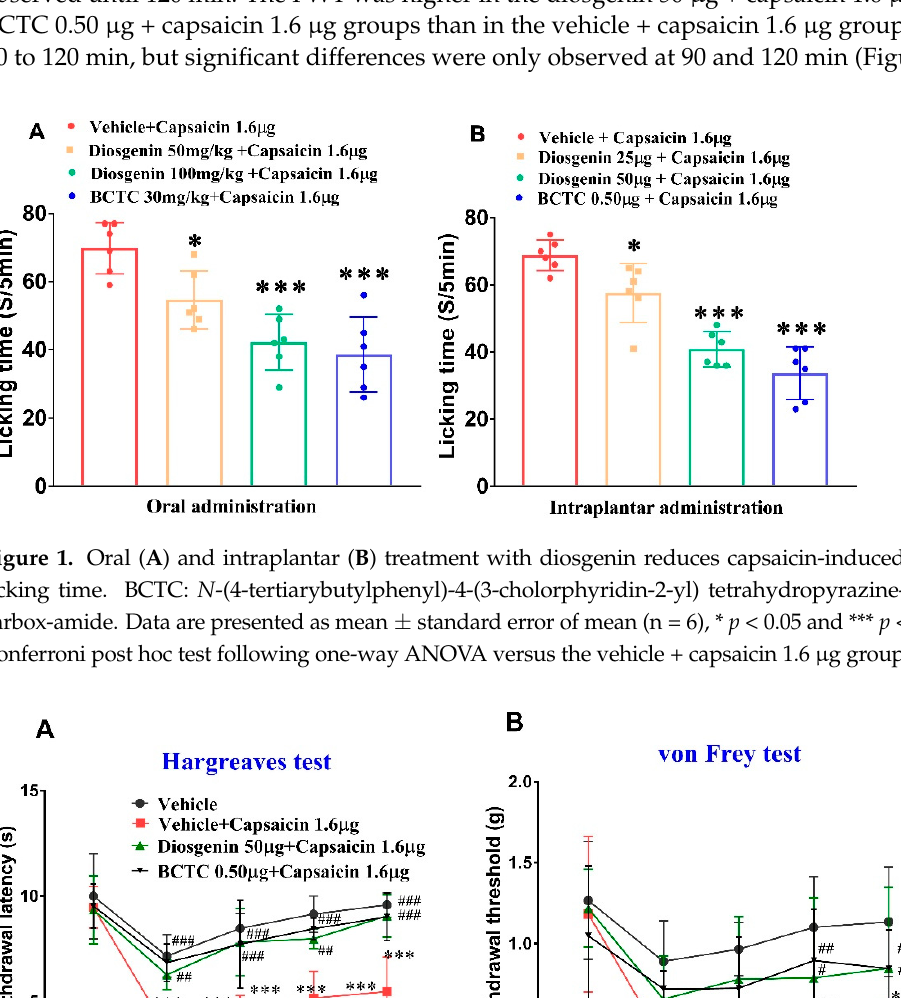
Figure 1. Oral ( A ) and intraplantar ( B ) treatment with diosgenin reduces capsaicin-induced acute licking time. BCTC: N -(4-tertiarybutylphenyl)-4-(3-cholorphyridin-2-yl) tetrahydropyrazine-1(2H)- carbox-amide. Data are presented as mean ± standard error of mean (n = 6), * p < 0.05 and *** p < 0.001, Bonferroni post hoc test following one-way ANOVA versus the vehicle + capsaicin 1.6 μ g group.